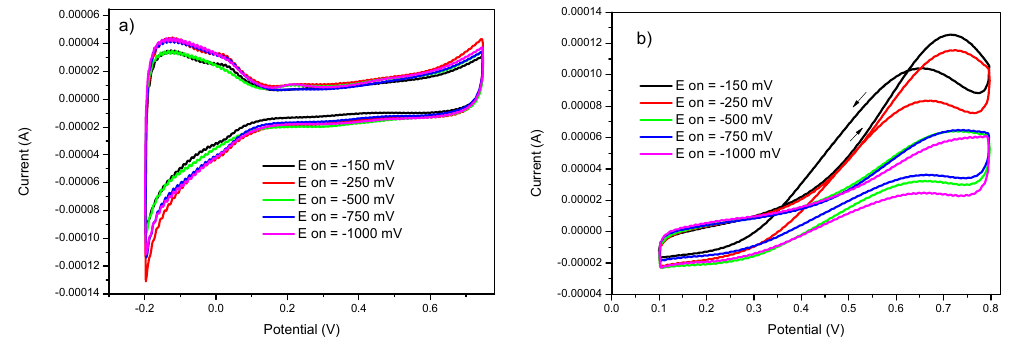
Figure 3. Cyclic voltammetry in ( a ) 0.5 M H 2 SO 4 and in ( b ) 2 M methanol +0.5 M H 2 SO 4 of GC/PANI(CV)/PtNPs electrodes obtained at various deposition potentials E on = − 150, − 250, − 500, − 750 and − 1000 mV.